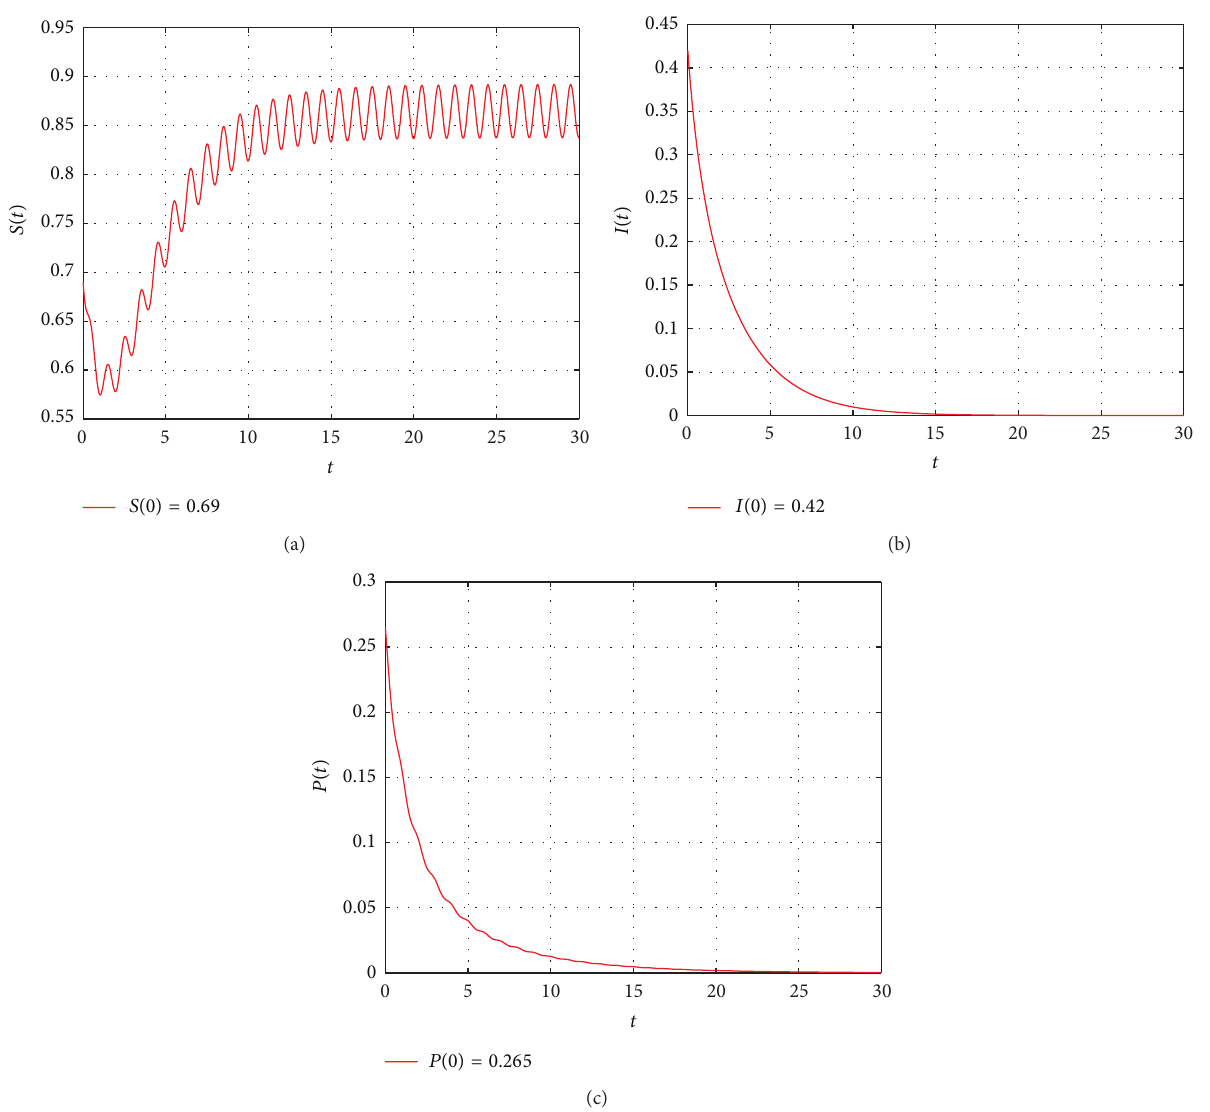
Figure 1: Partial extinction of system (80) with 𝛼 𝑘 = 0 , 𝑝 = 0 , and 𝛾 𝑘 = 0 . (a) Time series of 𝑆 for 𝑡 ∈ [0,30] . (b) Time series of 𝐼 for 𝑡 ∈ [0, 30] . (c) Time series of 𝑃 for 𝑡 ∈ [0, 30]